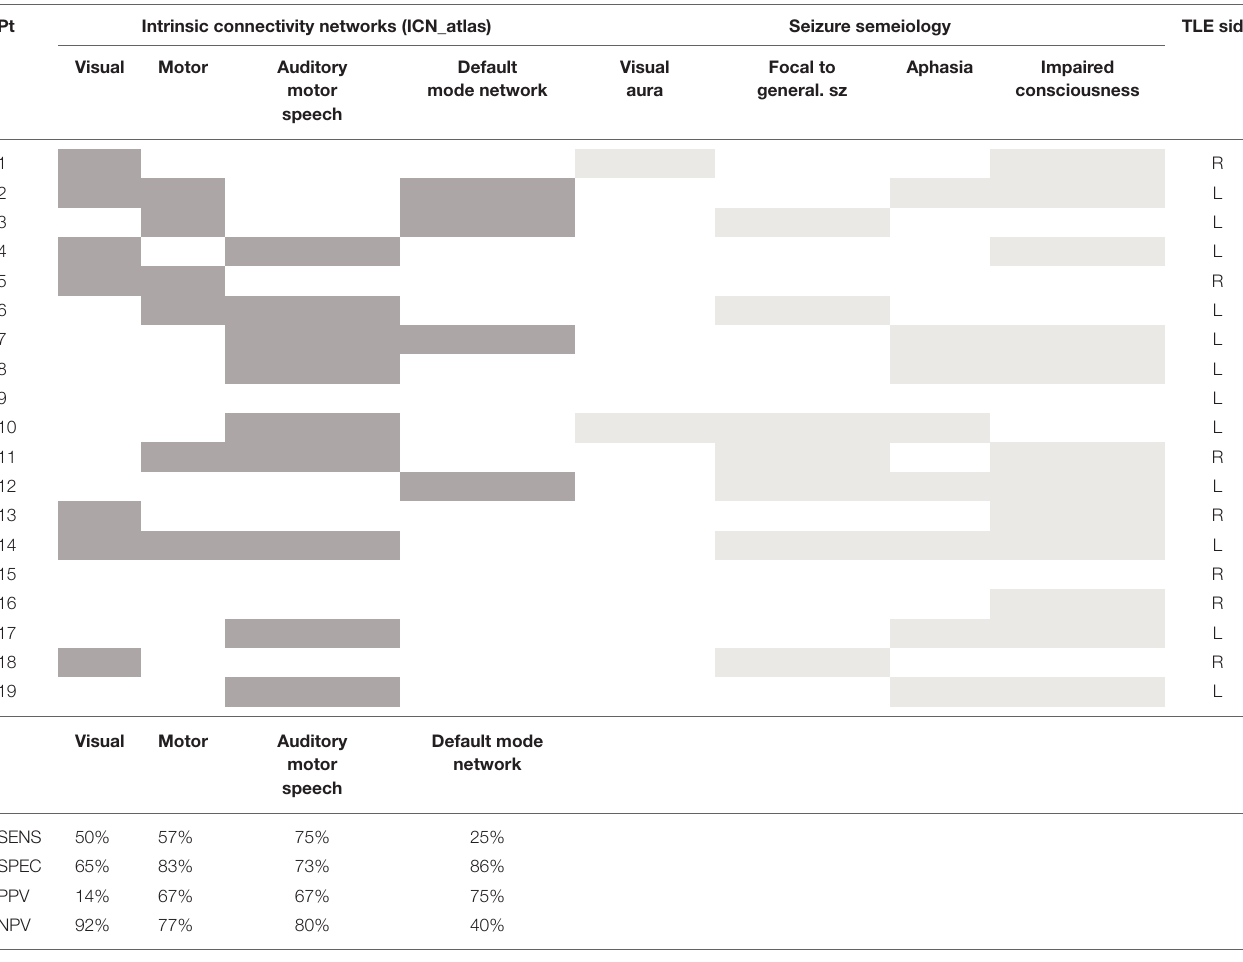
Visual Focal to Aphasia aura general. sz